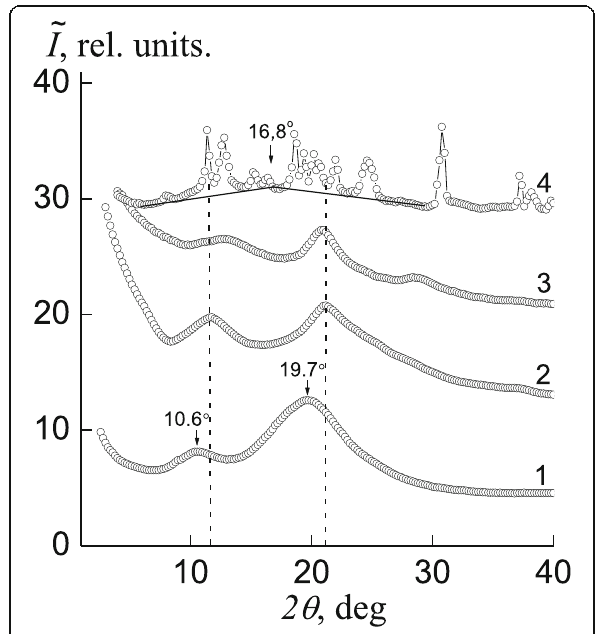
Fig. 1 WAXS of 1 P4VP, 2 the IPEC pectin – P4VP, 3 a pectin film, and